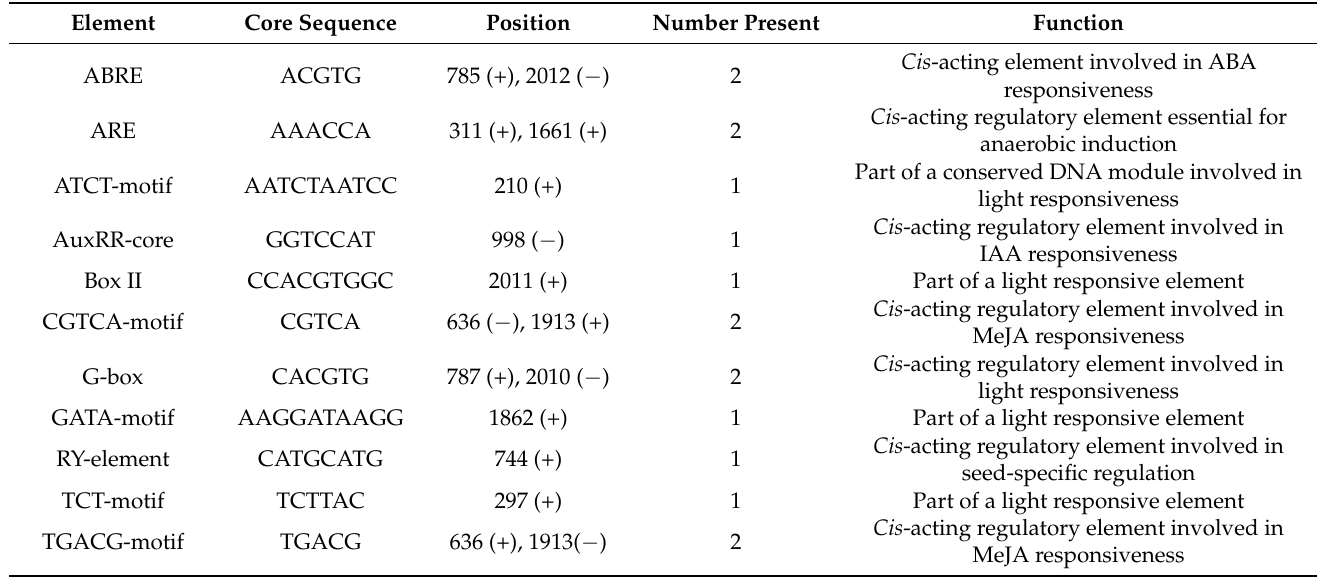
Table 4. Predicted positions and functions of cis-regulatory elements in the GmRIQ2 promoter ( PGmRIQ2 ).